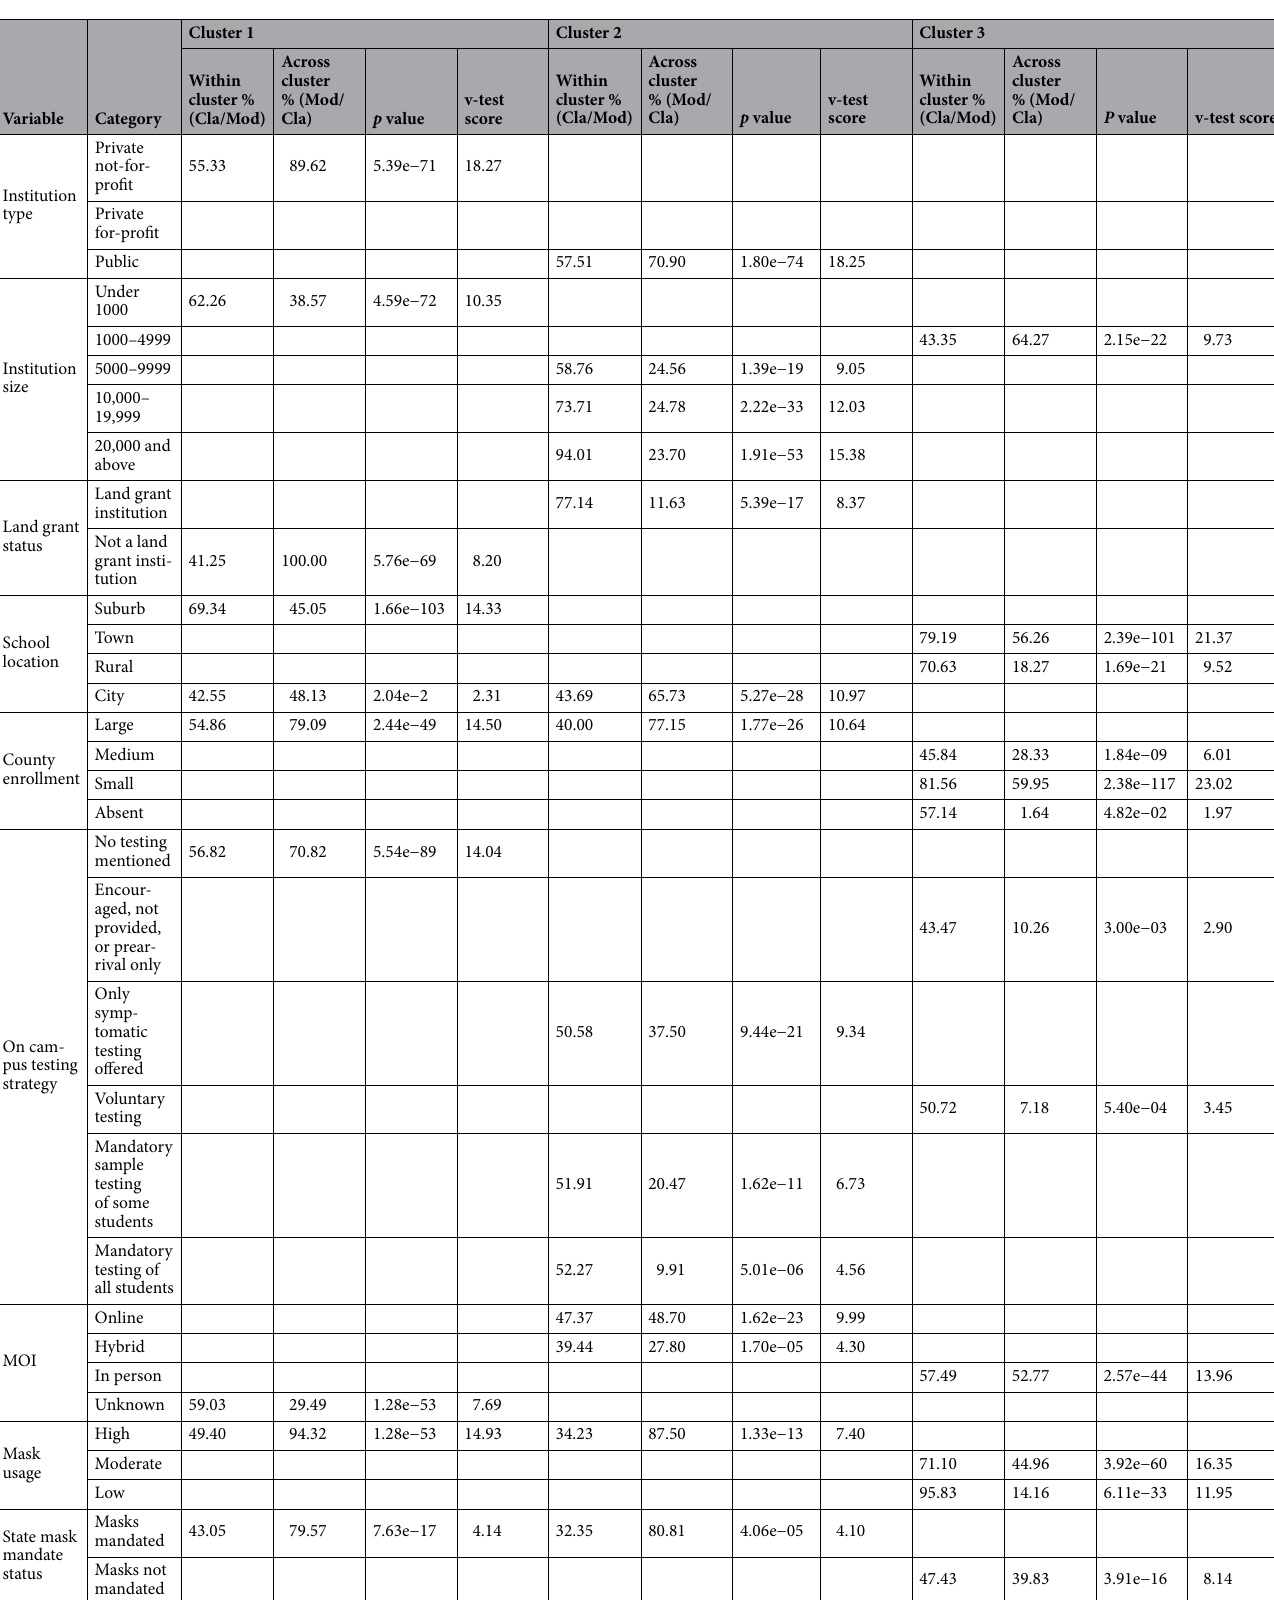
Table 5. Within-cluster (Mod.Cla; percentages of individuals who fit this description are in this cluster) and across-cluster (Cla.Mod; this percentage of individuals in this cluster fit this description) distributions of variables. V-test values greater than 1.96 correspond to a p values less than 0.05; and indicate an over- represented variable for the category. Only variables with a p value < 0.05 are included as this shows that one category is significantly linked to the other